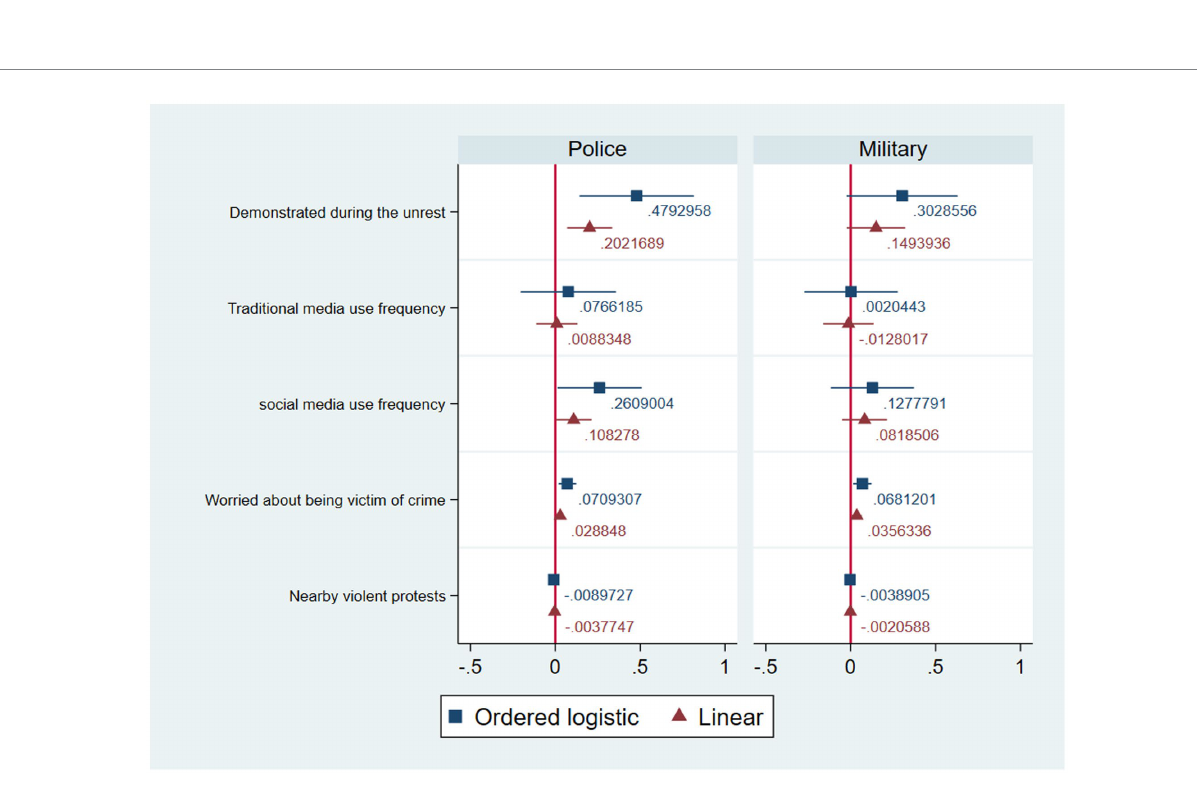
FIGURE 3 Regressions of perceptions of frequency of human rights violations by the police and military during the October crisis (traditional and social media), with 95% confidence